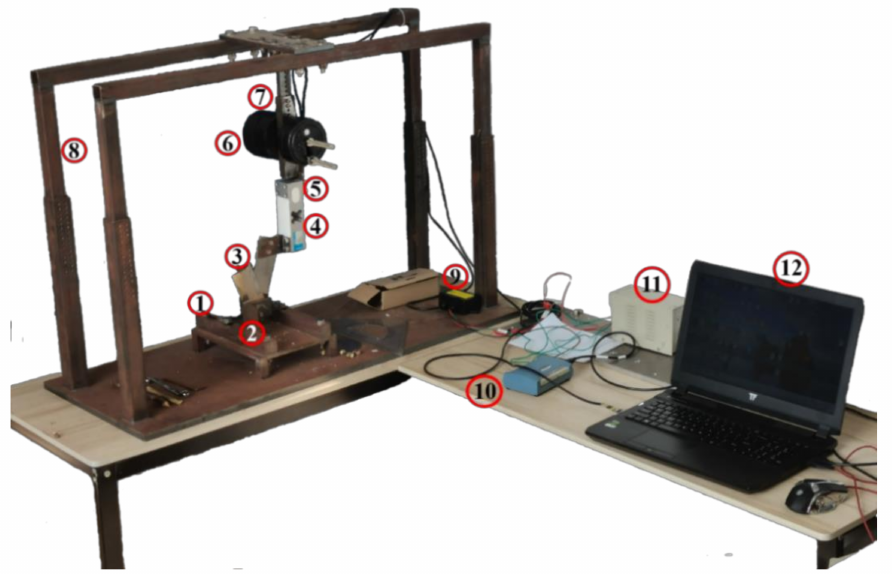
Figure 1. Schematic diagram of the structure of the pendulum-cutting test bench. 1. Support frame; 2. Branch fixture; 3. Cutting tool; 4. Foot-standing sensor; 5. Posture Euler angle sensor; 6. Counterweight block; 7. Pendulum 8. Table frame; 9. Transmitter; 10. Data acquisition card; 11. power supply; 12.